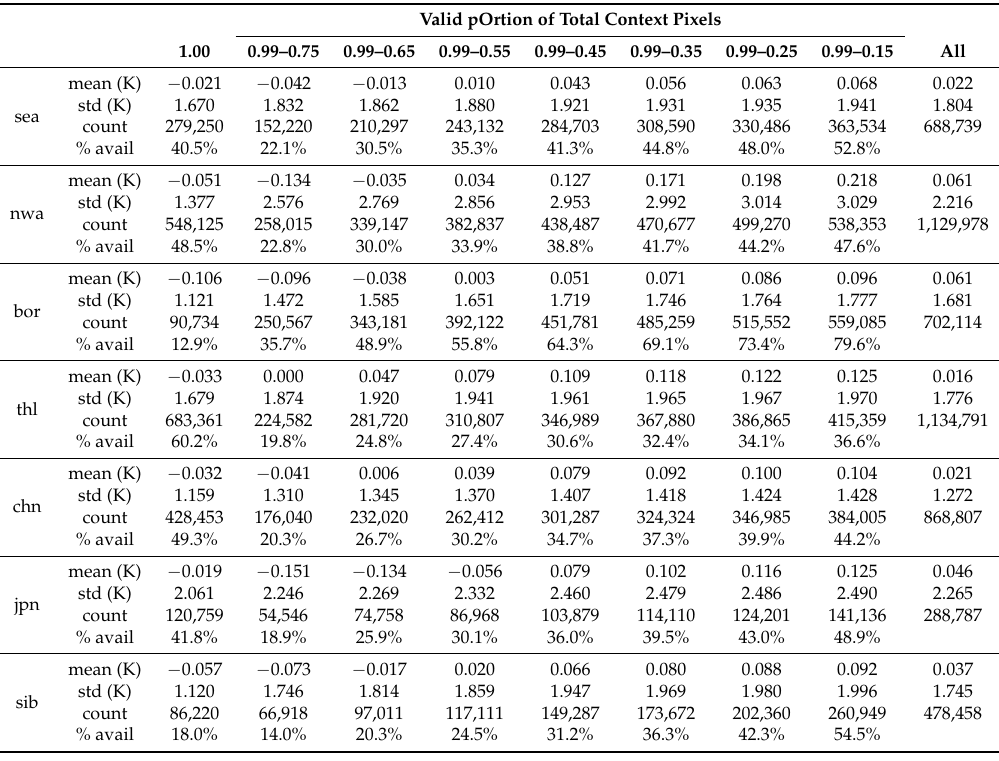
Table 8. Mean and standard deviation of brightness temperature differences between the central pixels and the contextual surrounds at the specified percentage levels for the 5 × 5 window in each case study area. Each column reports the statistics of accepting the available pixels above the denoted percentage level. Pixels with full contextual coverage are reported in the 1.00